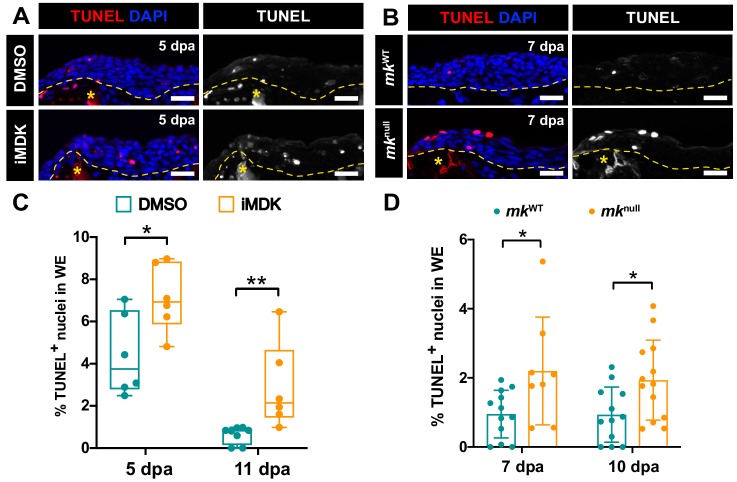
Mk acts as a critical survival factor during AEC development.(A) Representative TUNEL-stained sections from limbs of DMSO and iMDK-treated limbs. (B) Representative TUNEL-stained sections from limbs of regenerating mkWT control or mknull mutants. (C) Quantification of the % TUNEL+ nuclei in the wound epidermis of DMSO or iMDK-treated limbs limbs at 5 dpa (N = 6 DMSO, 6 iMDK) or 11 dpa (N = 8 DMSO, 6 iMDK). (D) Quantification of the percentage of TUNEL+ nuclei in mkWT control and mknull mutants at 7 dpa (N = 12 mkWT, 8 mknull) and 10 dpa (N = 12 mkWT, 13 mknull). Asterisks mark auto-fluorescent bone. Each N represents a limb from a different animal. Quantification of levels of blastemal cell death in DMSO/iMDK-treated and mkWT/mknull regenerating limbs can be found in Figure 5—figure supplement 1. Two-tailed unpaired student’s t-tests were used for statistical analysis. Graphs are mean ± SD. *p<0.05, **p<0.005. Scale bars: 100 µm. dpa, days post-amputation.